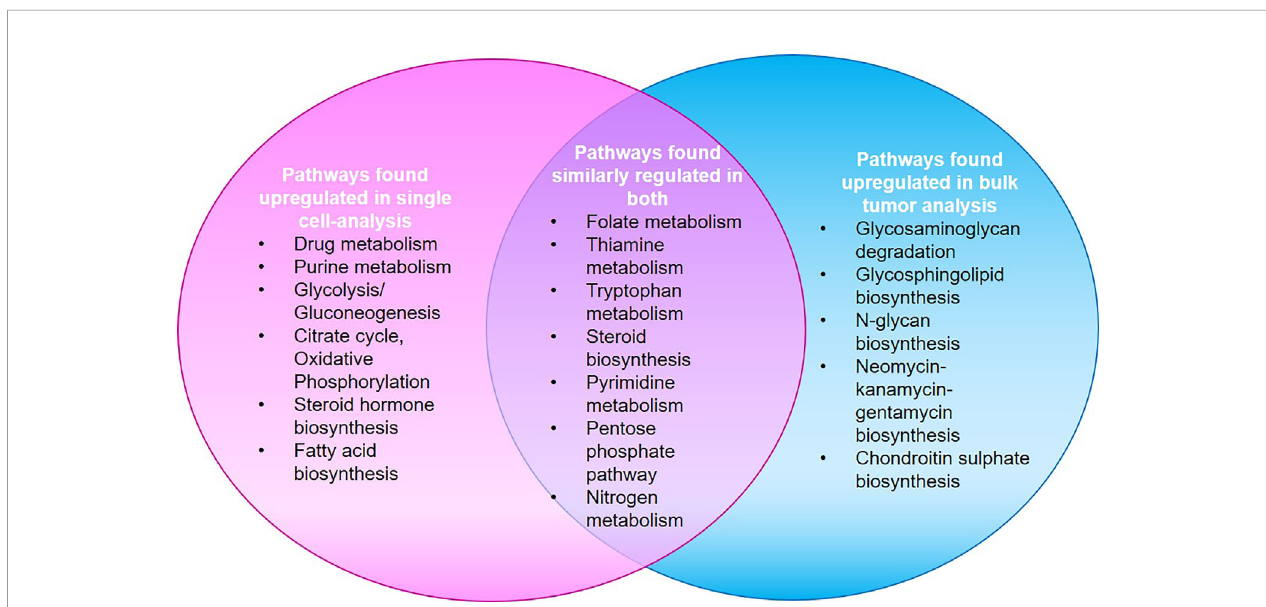
FIGURE 5 | A study by Xiao et al. shows that major metabolic pathways found up-regulated in single cell analysis were found downregulated in bulk-tumor analyses and vice-versa. Twenty-four pathways showed similar up-regulation/down-regulation patterns in both as represented by the intersection in Venn